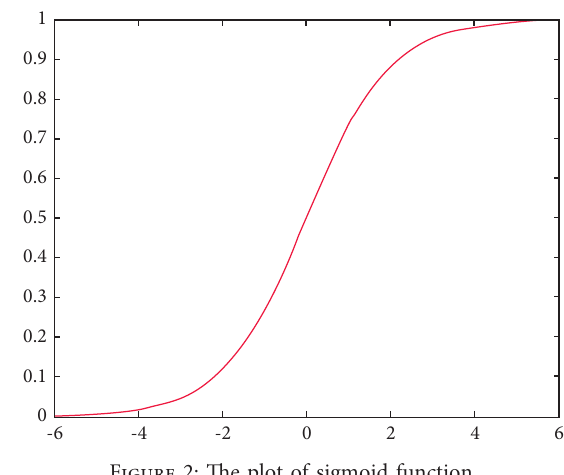
Figure 2: The plot of sigmoid